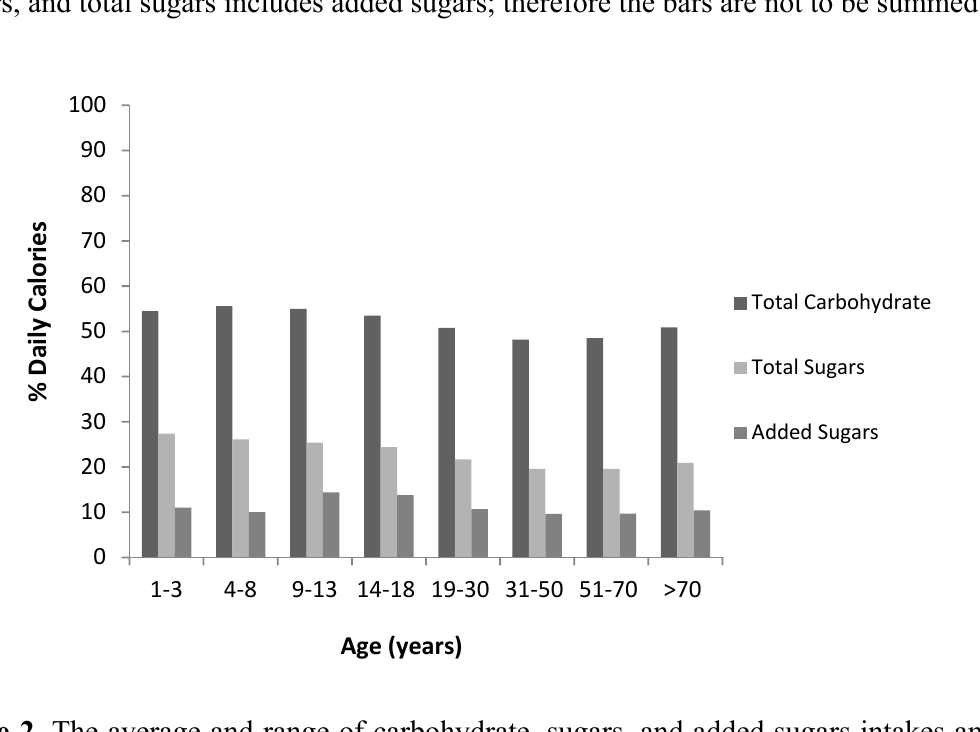
Figure 1. Average daily total carbohydrate, total sugars, and estimated added sugars intake (each as % calories) among Canadians according to Canadian Community Health Survey